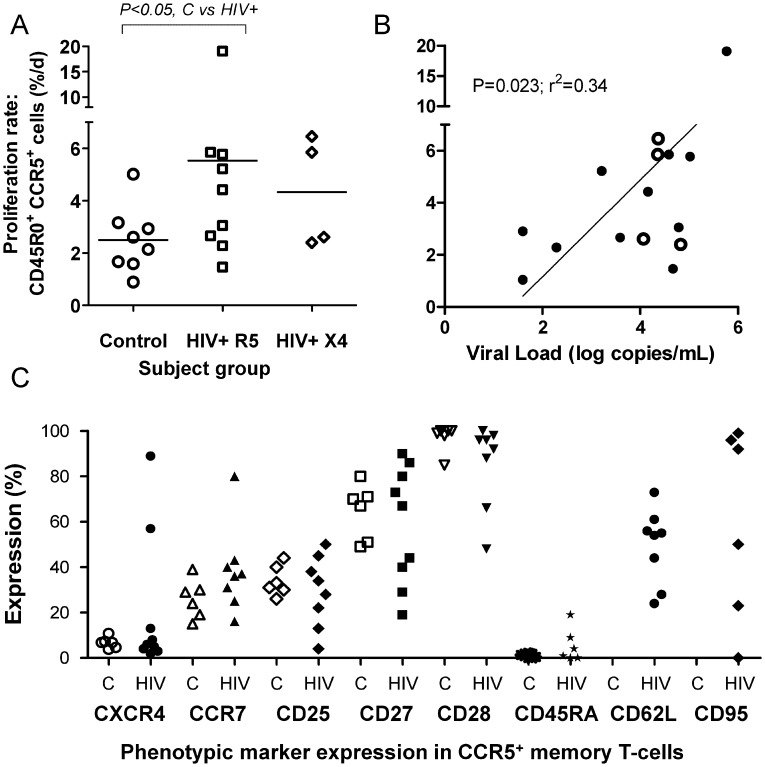
HIV infection accelerates turnover rates of CCR5-positive CD4+CD45R0+ memory T-cells.(A) Increased proliferation rates in HIV infected subjects (HIV+ R5, HIV-positive subjects with R5-tropic virus; HIV+ X4, HIV-positive subjects with X4-tropic virus) compared to controls (P<0.05 by Mann Whitney test as data skewed). (B) Correlation of CCR5+ T-cell turnover with viral load in viremic HIV+ subjects (open circles are subjects with X4-tropic virus; P = 0.044, r2 = 0.28 using log-transformed data). (C) Phenotype profile of CCR5+ memory T-cells in healthy controls (C, open symbols) and HIV+ subjects (H, filled symbols). CD62L and CD95 data were not available for control subjects. P = NS for all comparisons between control and HIV+ by Mann Whitney test.